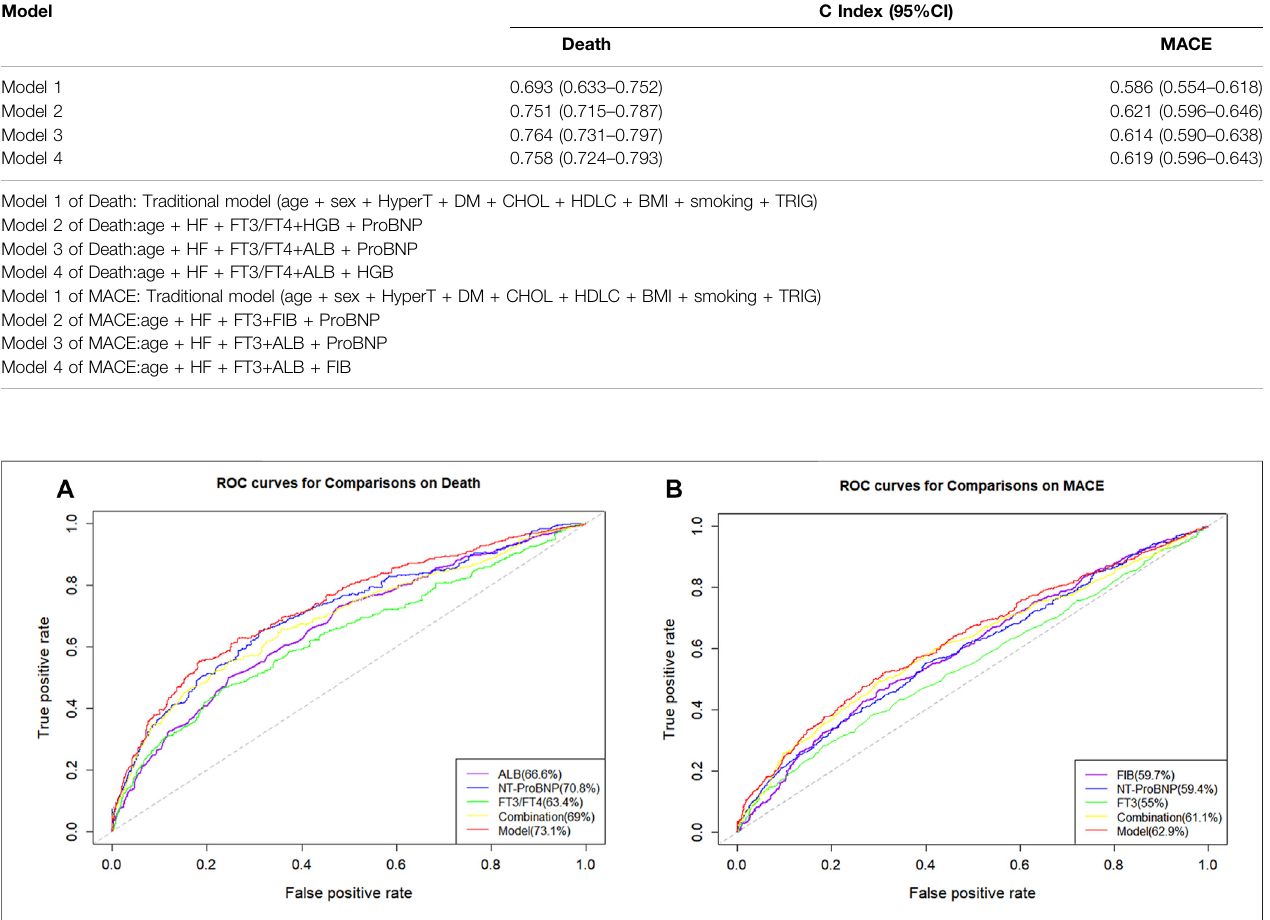
FIGURE5| Receiveroperatingcharacteristicscurves(ROC)ofdifferentparametersandmodels. (A) ROCcurvesofdifferentparametersandmodelsforpredicting all-cause mortality; (B) ROC curves of different parameters and models for predicting MACE.